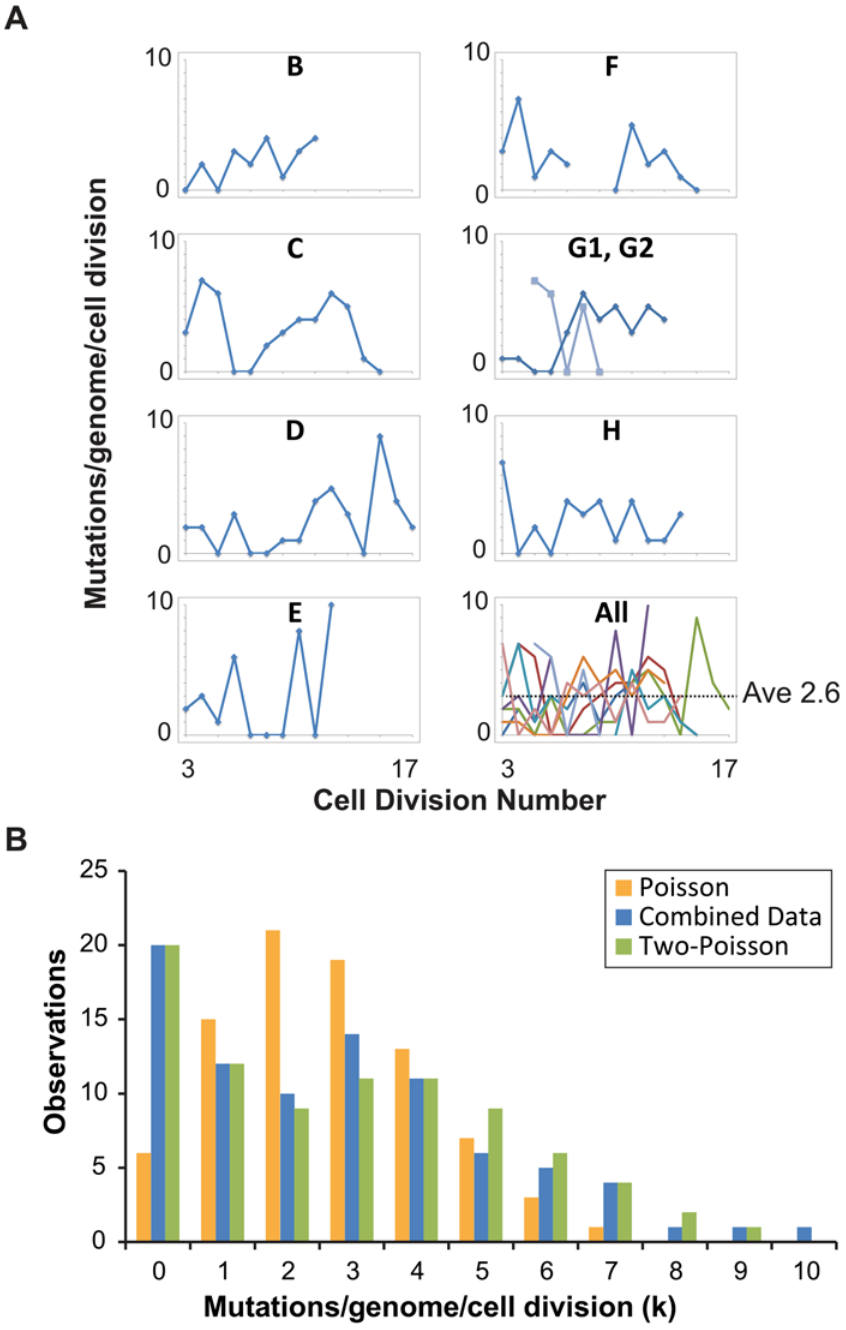
Fig 2. Distribution of single cell mutation counts in mother cells. (A) Mutation counts of mutator cells during yeast aging. Each lineage is plotted separately, except Lineage G, whose mother cell became multi- budded, producing two distinct lineages: G1 (blue) and G2 (light blue). The gap in Lineage F is due to sequencing failure of one of the daughter clones. Bottom right , all lineages are plotted together, each represented by a different line color. (B) The observed distribution (blue bars, combined data) of mutation counts is plotted against the predicted Poisson distribution based on the average genome-wide mutation rate (2.6 x 10 -7 mutations/bp/cell division) (orange bars, Poisson Model) and a composite distribution resulting from two overlapping Poisson distributions with mutation rates of 4 x 10 -8 (contributing 35%) and 4 x 10 -7 (contributing 65%) mutations/bp/cell division (green bars, Two-Poisson